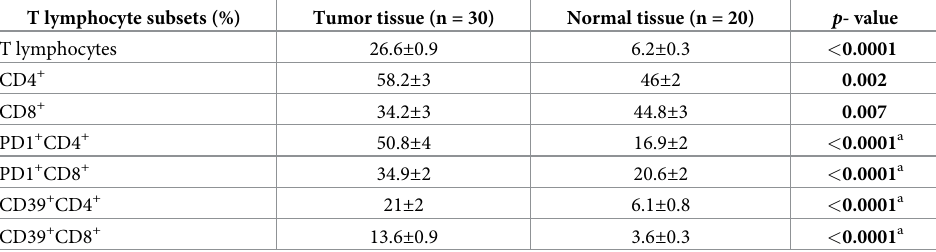
Table 2. Differential expression of PD1 and CD39 on T lymphocytes in tumor and normal breast tissue of patients with triple-negative breast cancer. T lymphocyte subsets (%) Tumor tissue (n =